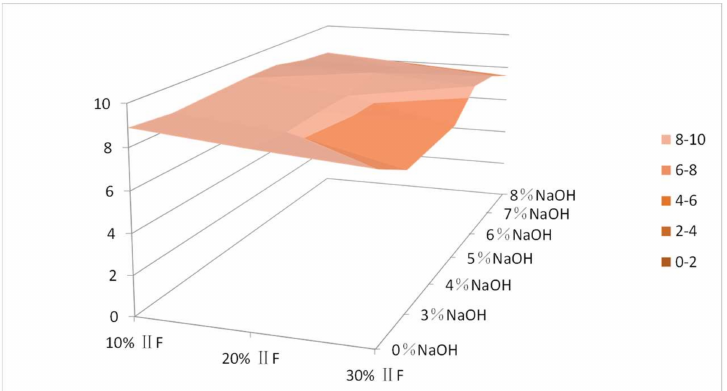
Figure 8. Response surface of flexural strength at 28